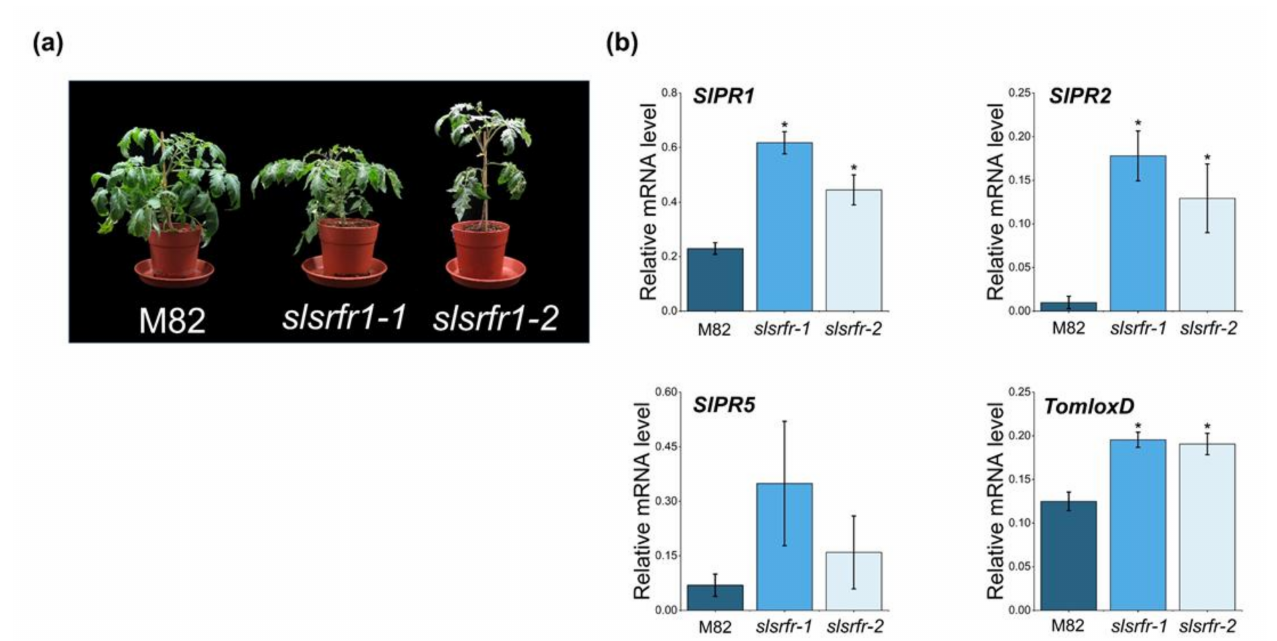
Figure 6. Altered morphology and expression of defense marker genes in CRISPR/Cas9-edited slsrfr1 plants. ( a ) Growth phenotype of 6-week-old M82 and slsrfr1 lines grown in 16 h light/8 h dark long-day photoperiod; ( b ) relative mRNA expression of defense-related genes. The genes used for gene expression analysis refer to SlPR1 (Solyc09g007010.1), SlPR2 (Solyc01g008620.2), SlPR5(Solyc08g080640), and TomloxD (Solyc03g122340.2). Gene expression levels of each gene were normalized with SlACT (Solyc04g011500.3.1) as an internal control. Error bars represent standard deviation. A statistically significant difference was determined by the Student’s t -test (* p < 0.01).